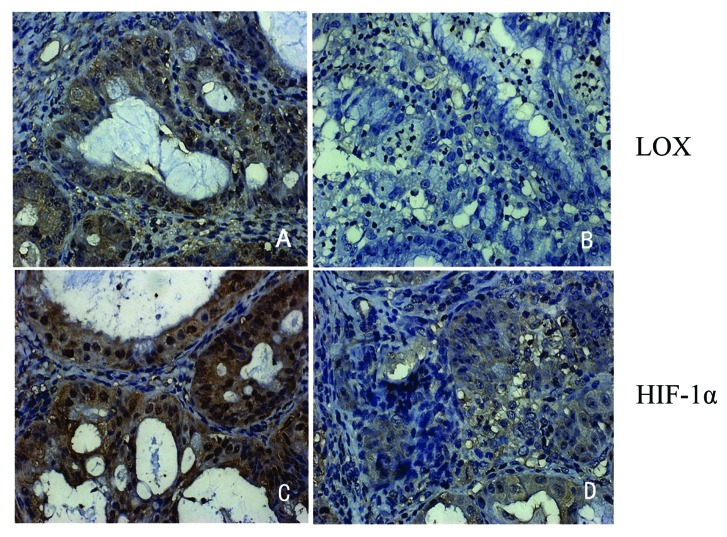
Immunohistochemical staining for LOX and HIF-1α in POEC. (A) Positive and (B) negative expression of LOX in POEC. (C) Strong and (D) weak positive expression of HIF-1α in POEC. Original magnification, ×200.